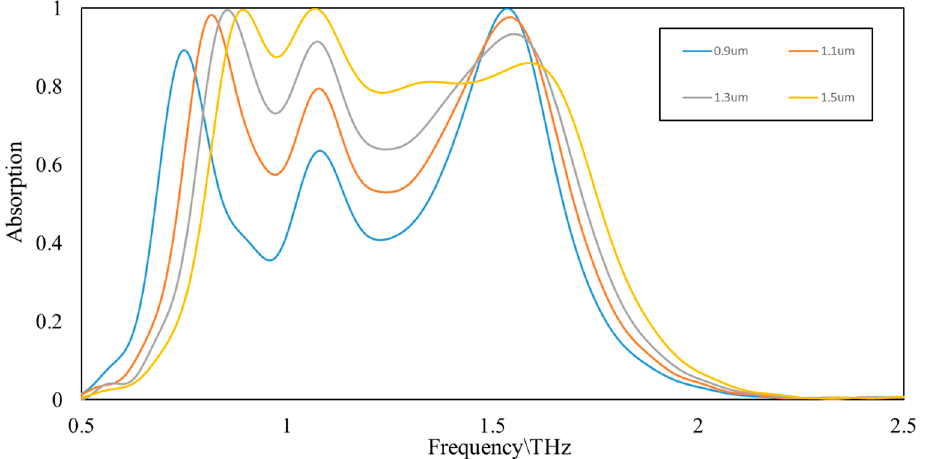
Figure 4. The simulated absorption spectrum of the absorber which the two rings’ sizes are constant (0.3 μ m and 0.5 μ m) and the biggest SGR’s size is varying from 0.9 μ m to 1.5 μ m. (The blue line is 0.9 (0.3 µ m and 0.5 µ m) and the biggest SGR’s size is varying from 0.9 µ m to 1.5 µ m. (The blue line is μ m, red line is 1.1 μ m, gray line is 1.3 μ m and orange line is 1.5 μ m). 0.9 µ m, red line is 1.1 µ m, gray line is 1.3 µ m and orange line is 1.5 µ